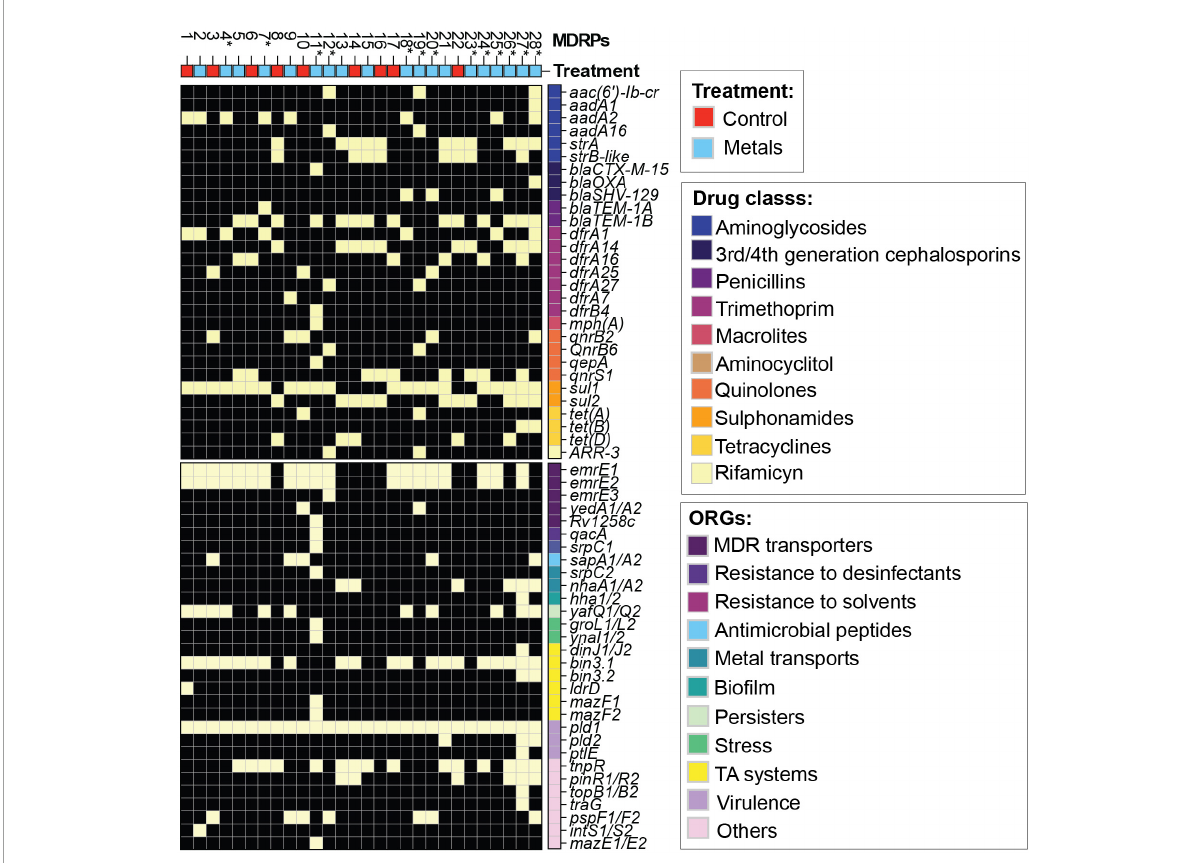
FIGURE6 Genomic characterization of representative transconjugants with unique MDRP. Heatmap based on the presence (yellow)/absence (black) of ARGs annotated using the ResFinder database (Bortolaia et al., 2020). ARGs were classified according to the drug class they belong to. Other relevant genes (ORGs) were labeled based on their biological function. Unique MDRPs are marked with